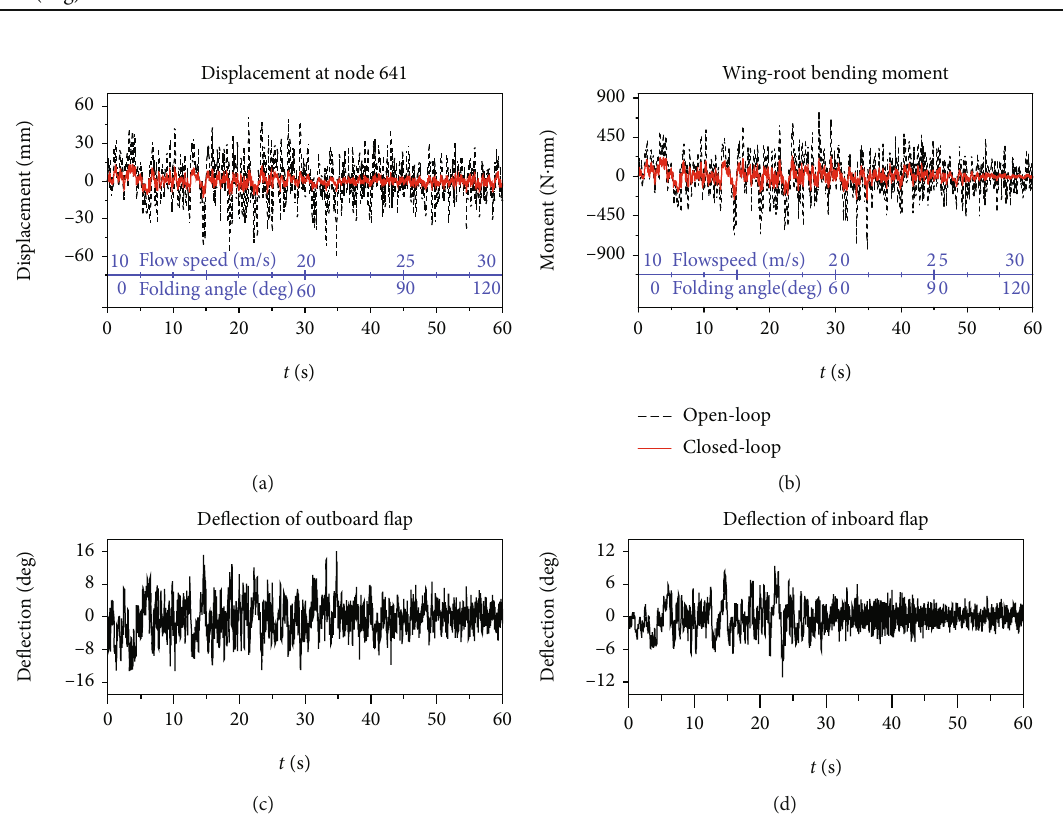
Figure 20: Dynamic responses of the open and closed-loop systems to continuous gust under the time-varying folding angle and fl ow speed.